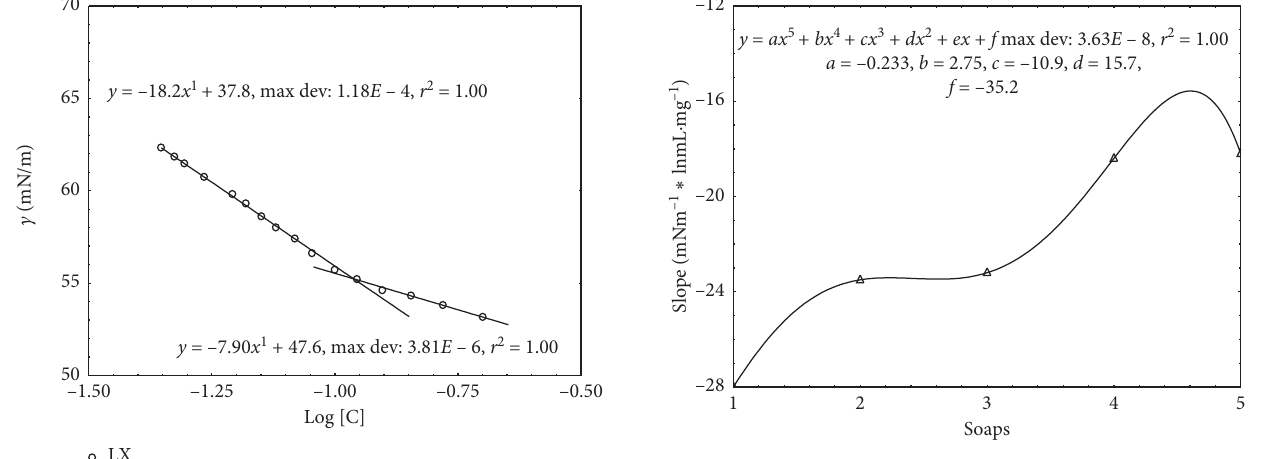
Figure 9: Plot of surface tension versus concentration of a rep- resenting soap (LX) solution at 303.15K.